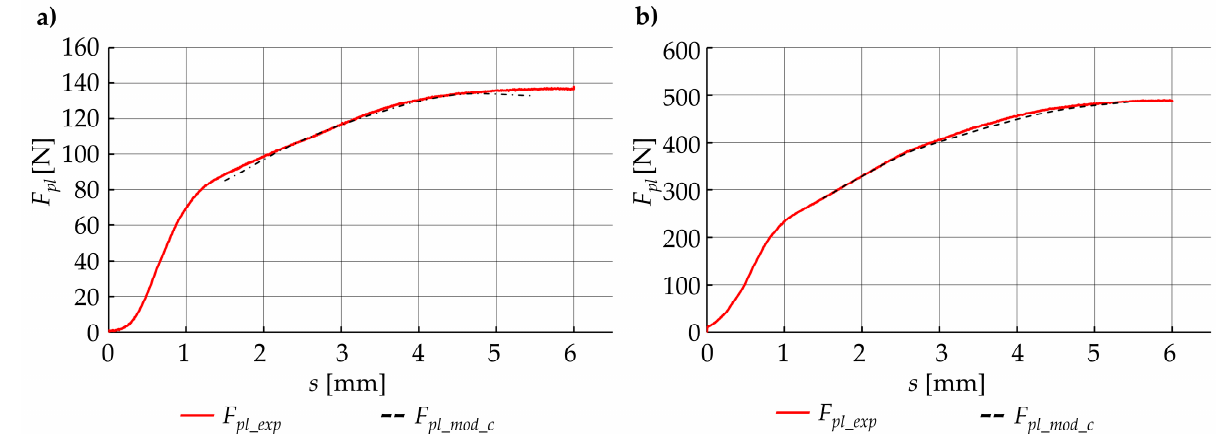
Figure 22. Examples of the characteristics of the plasticization force F pl ( s ) concerning the aspect of comparison between values of experimental research ( F pl_exp ) and from the derivative model ( F pl_mod ): ( a ) belt with diameter of 12 mm, hot plate temperature T p = 285 °C, plasticization velocity v pl = 10 mm/min, ( b ) belt with diameter of 18 mm, hot plate temperature T p = 285 °C, plasticization velocity v pl = 8 mm/min.